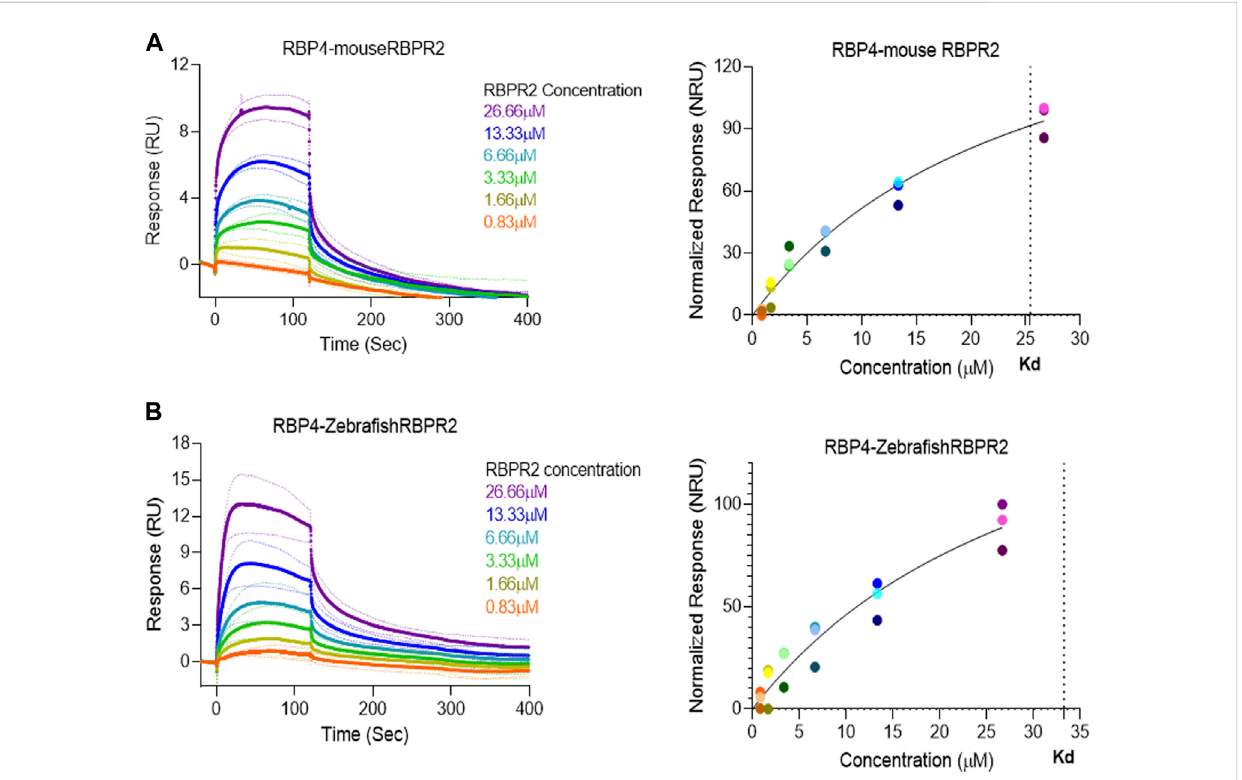
FIGURE 5 SurfacePlasmonResonancebindingstudiesbetweenRBPR2anditsligandRBP4.BindingstudiesusingSPRbetweenmouseRBPR2 (A) andZebra fi sh RBPR2 (B) and immobilized mouse RBP4 protein is shown, together with the respective kinetic values ( K d ) in the right panel. The interaction levels are measured in response units (RU) and real time plot sensorgram display the dynamics of the analysis.